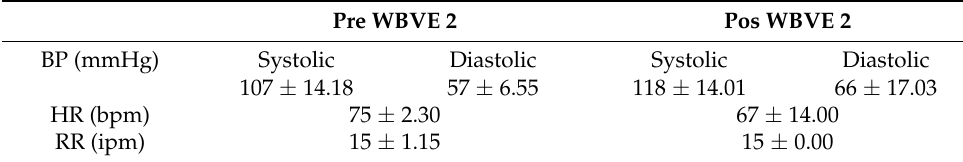
Table 2. Results of the second WBVE intervention on clinical